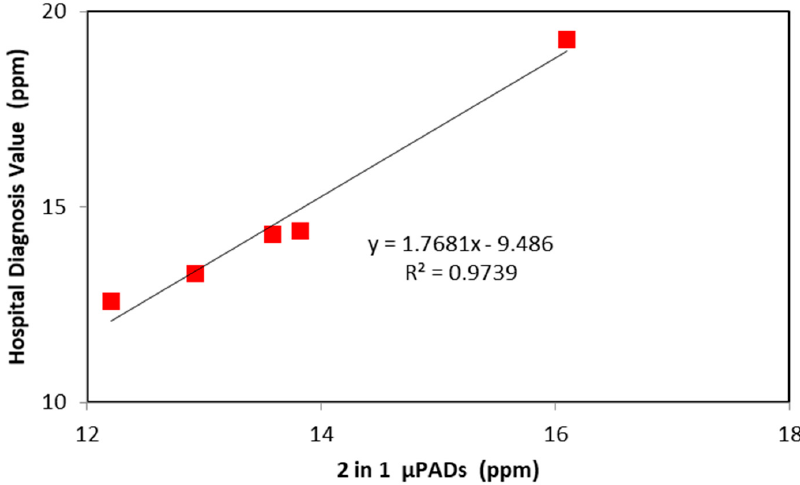
Figure 5. Linear regression analysis of creatinine detection, with the vertical axis indicating the clinical value of creatinine concentration, and the horizontal axis indicating the PAD-determined value of creatinine concentration.